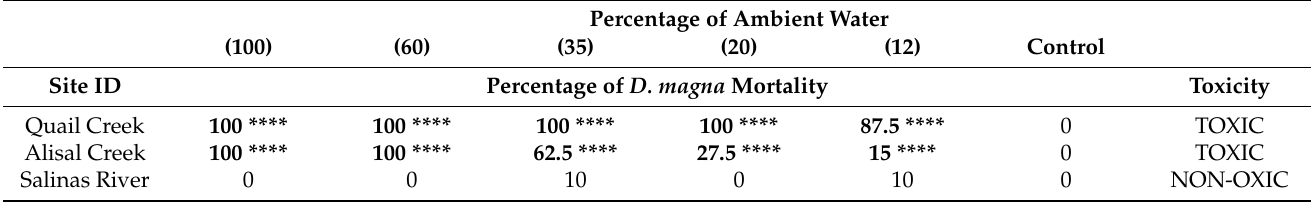
Table 1. Mortality of D. magna throughout a 96 h exposure to serial dilutions of water samples from 3 sites located throughout the Salinas River (CA, USA) collected September 2019 (before first flush). Significance of mortality relative to control group is shown as **** = p ≤